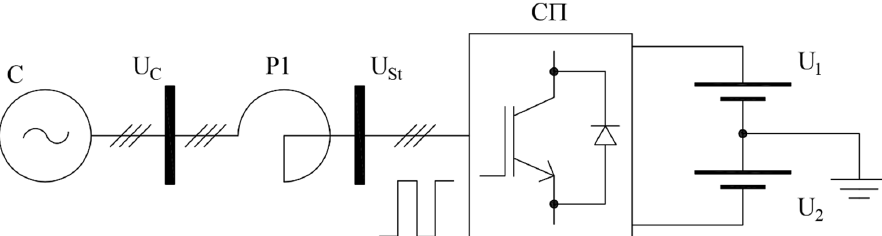
Figure 1. Static synchronous compensator (STATCOM) simplified concept with voltage converter.